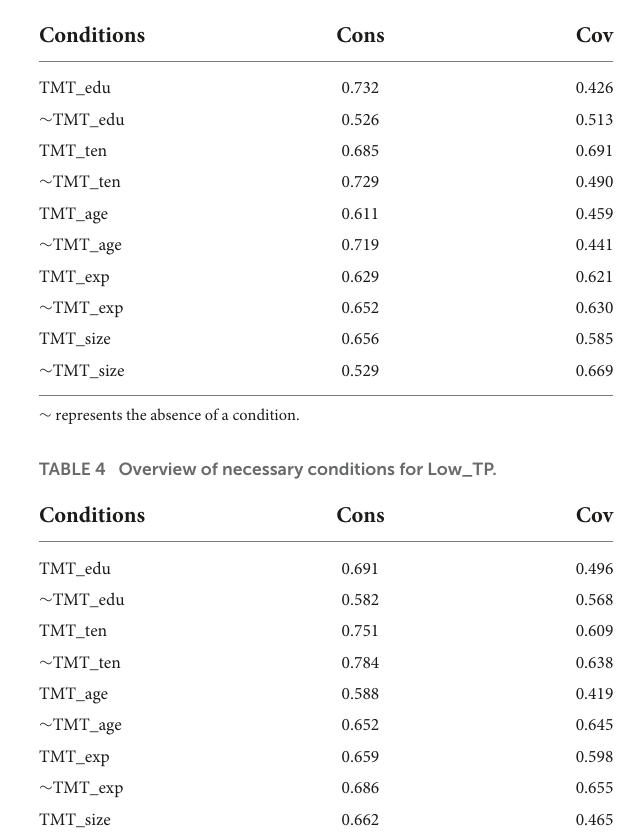
TABLE 3 Overview of necessary conditions for High_TP.